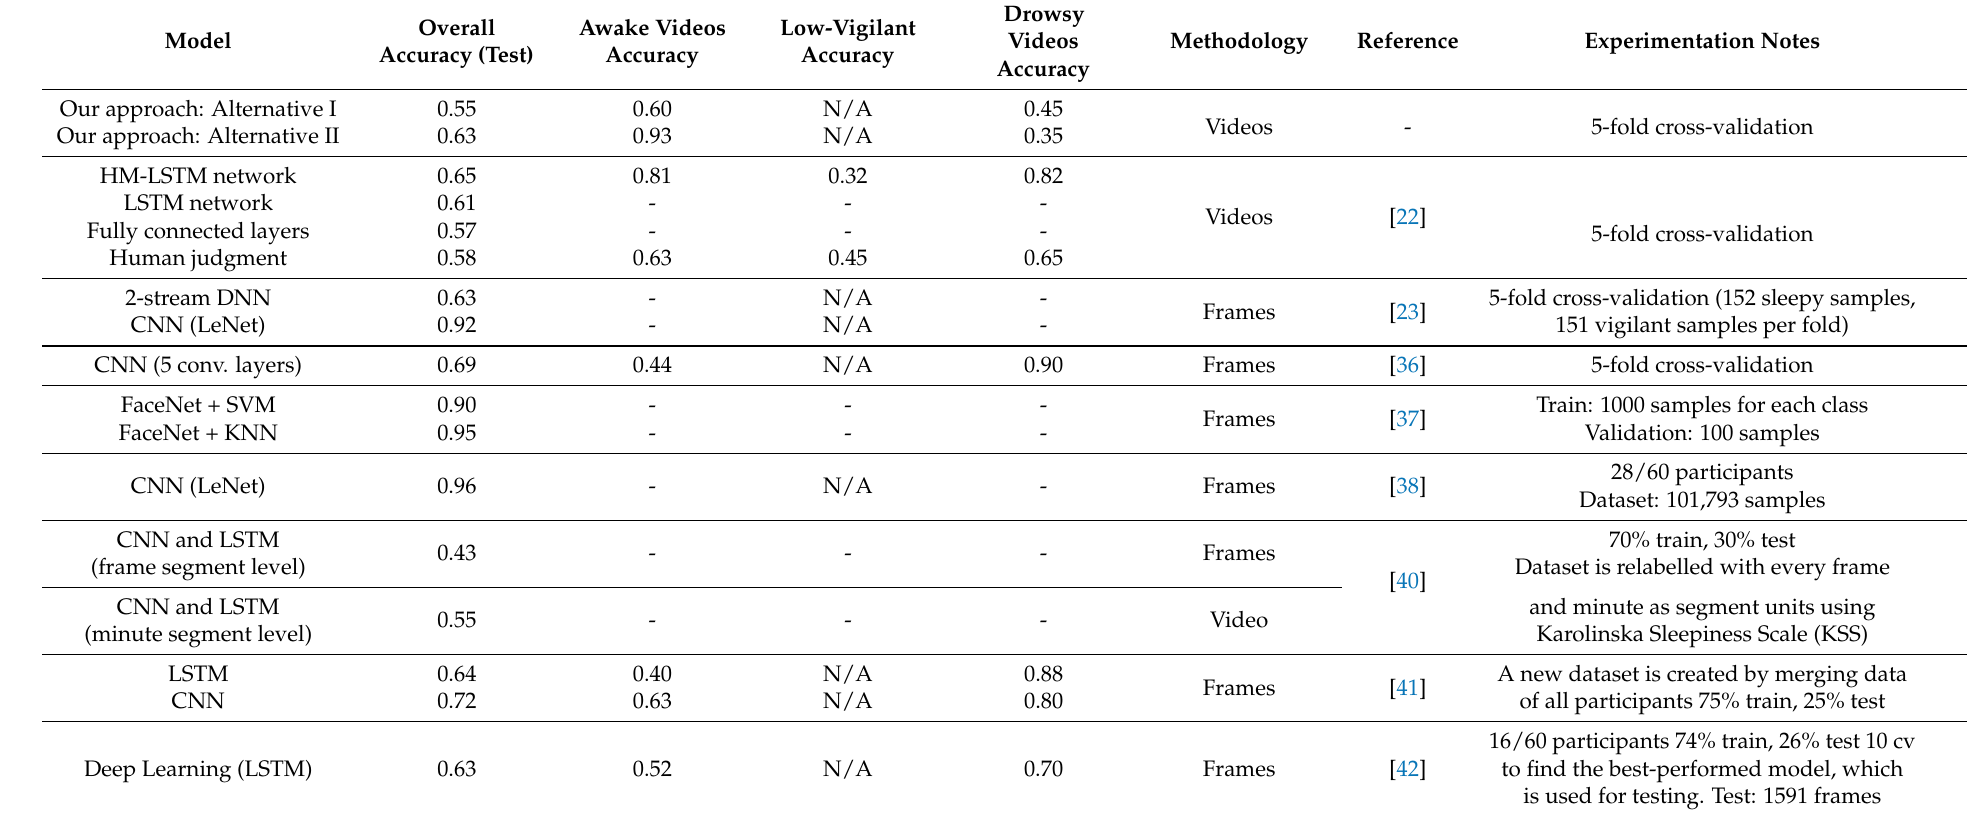
Table 11. Comparison of results obtained by systems that predict fatigue over UTA-RLDD